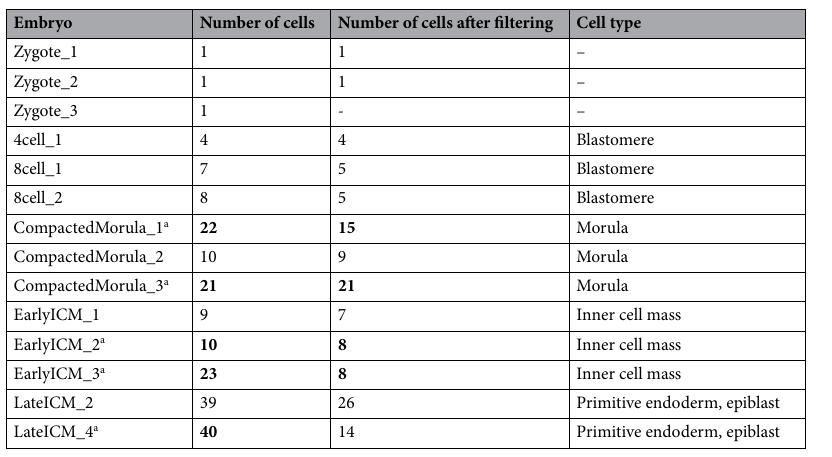
Table 1. Summary of embryos and cells analyzed. a Female